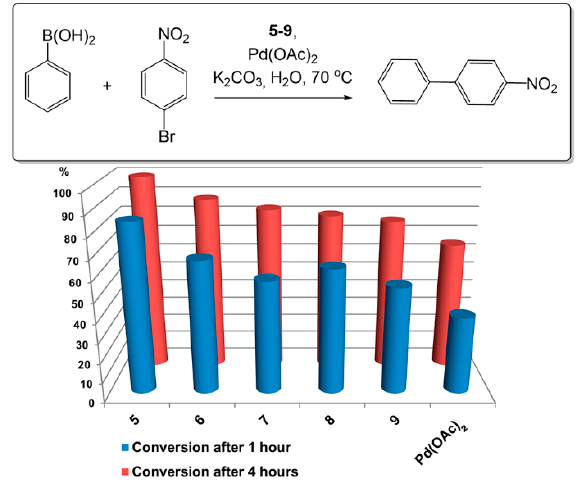
Figure 3. Conversion of 1-bromo-4-nitrobenzene after 1 or 4 h of reaction upon reaction with phenylboronic acid. C (1-bromo-4-nitrobenzene) = 10 mM, C (phenylboronic acid) = 11 mM, C (K 2 CO 3 ) = 30 mM, C (Pd(OAc) 2 ) = 50 μ M, C( 5 – 9 ) = 1.5× CAC μ M, H 2 O, 70 °C. Table 2. (TON) and turnover frequency (TOF) values for coupling of 1-bromo-4-nitrobenzene with phenylboronic acid using di ff erent catalytic